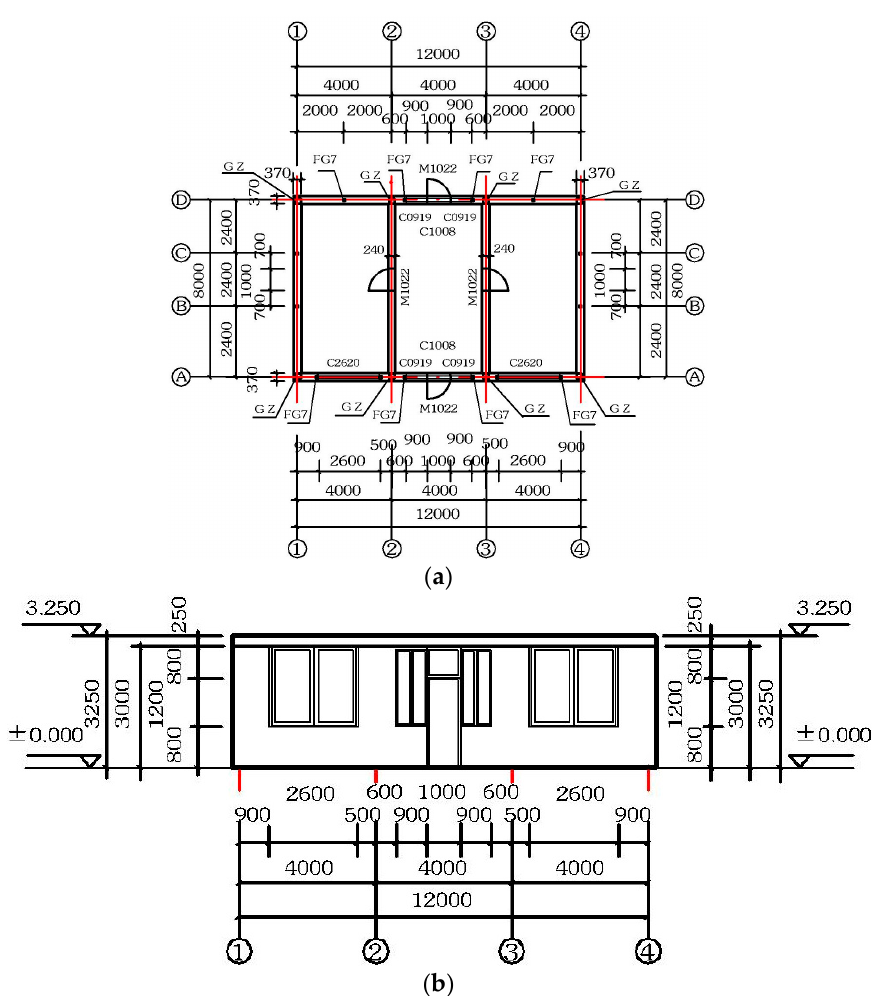
Figure 10. Arrangement plan of structure: ( a ) floor plan of structure; and ( b ) elevation drawing of structure.